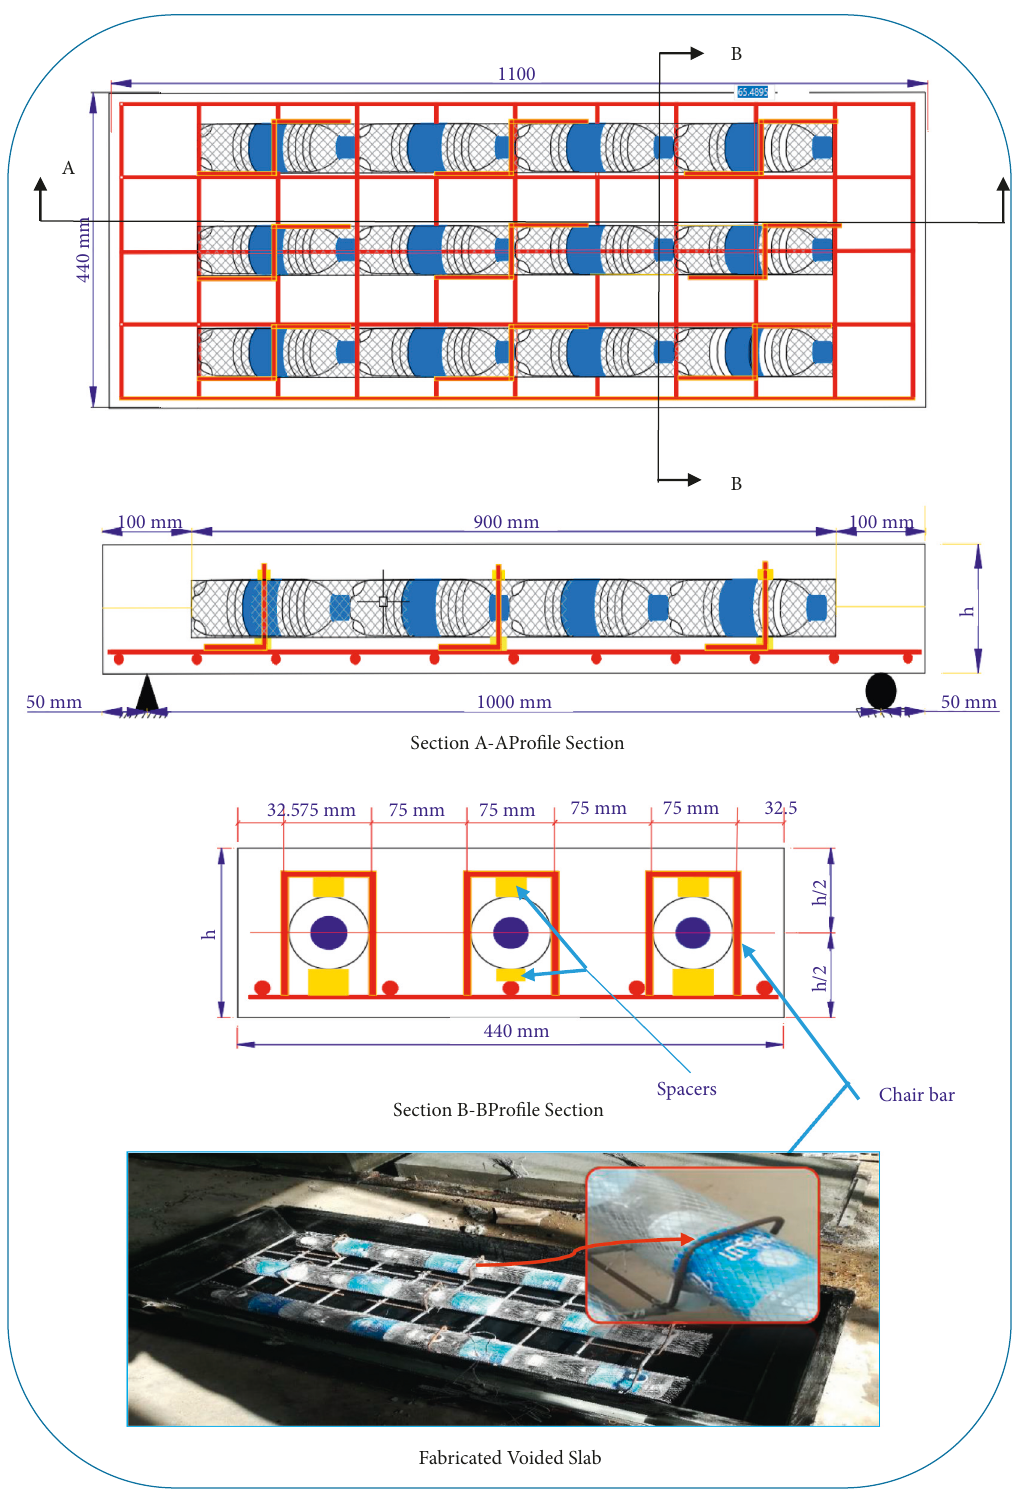
Figure 3: The details of voided